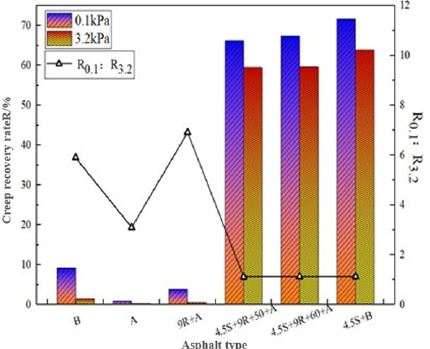
Figure 3. Comparison of R for different asphalt types in the Figure.